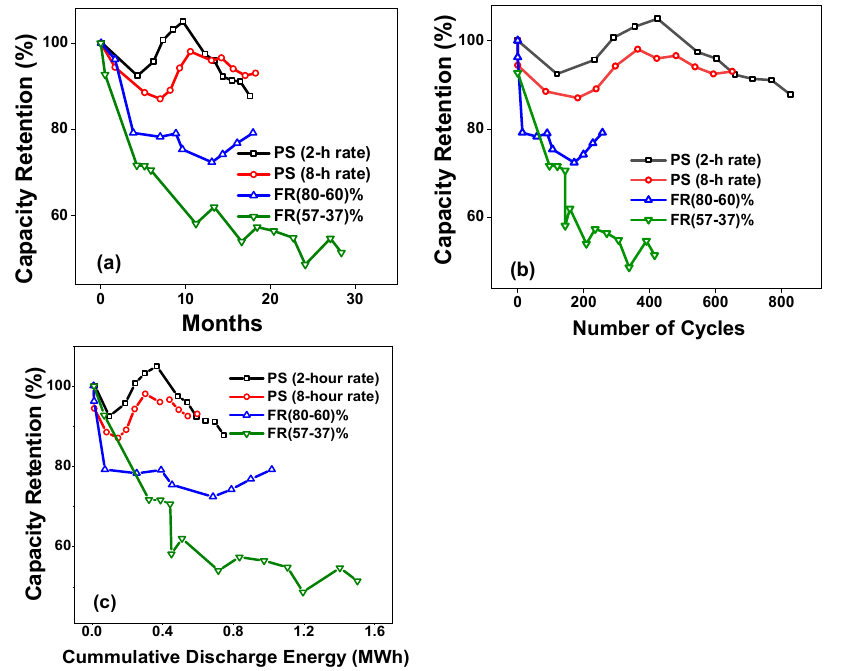
Figure 4. Capacity retention vs. ( a ) months ( b ) number of cycles and ( c ) cumulative discharge energy for four different duty cycles.